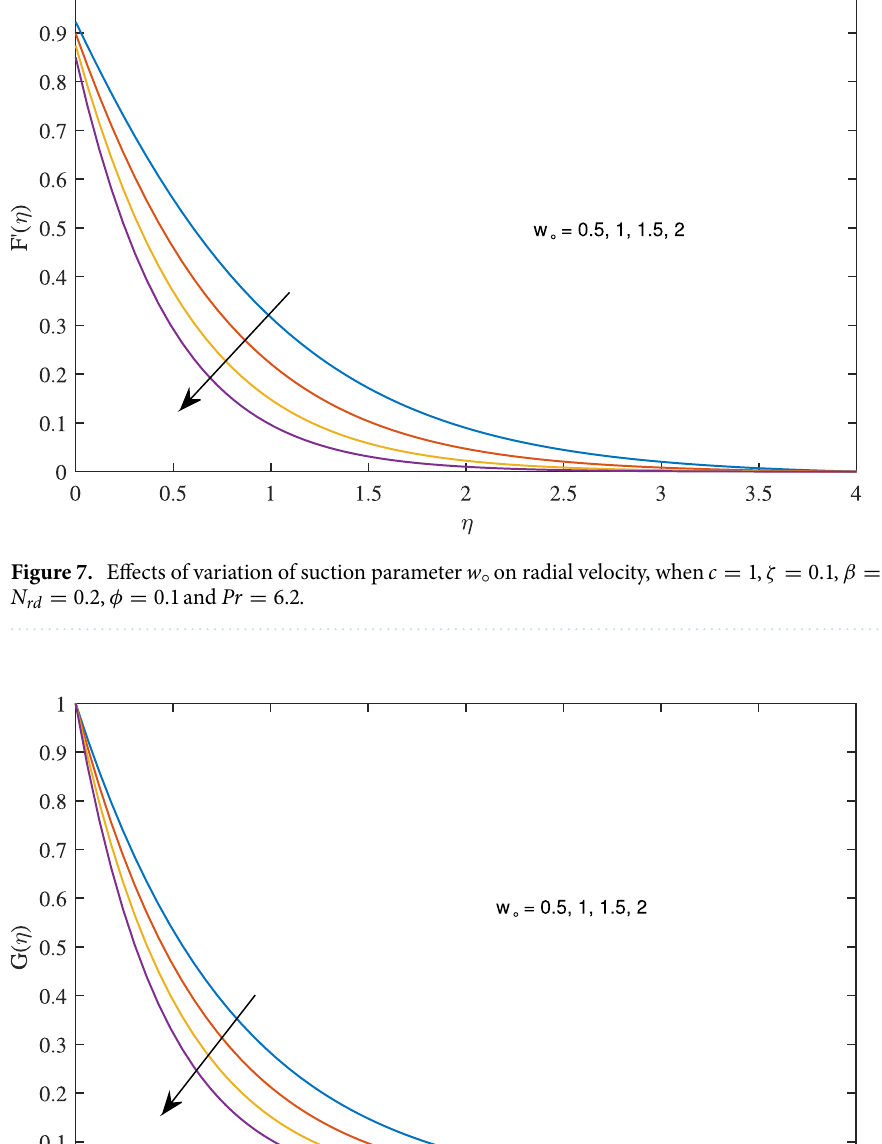
1 , ζ 0.1 , β 0.2 , N 0.2 , rd = = = =